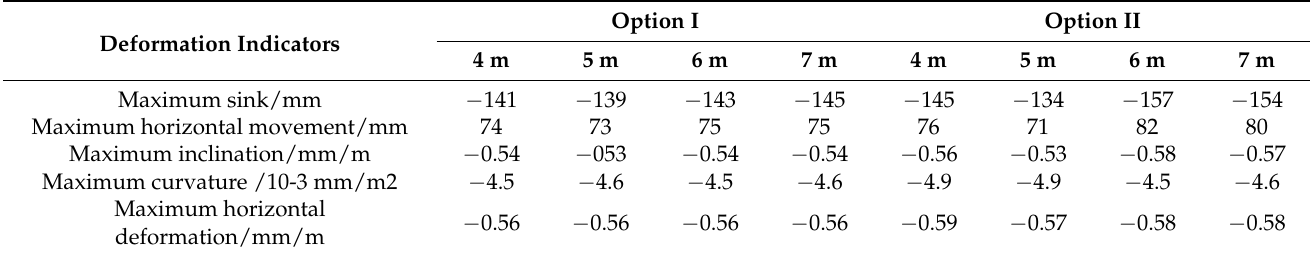
Table 6. Surface deformation under different mining width conditions.